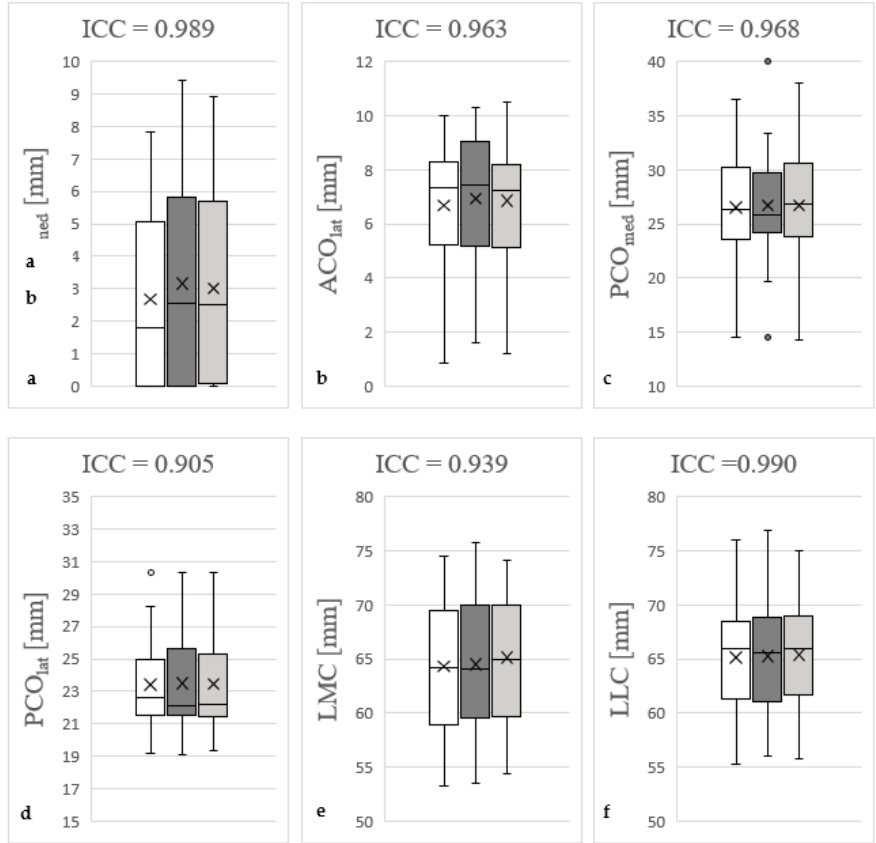
Figure 4. Determination of intraclass/interclass correlation coefficient (ICC) of medial anterior femoral condylar offset (ACO med ), ( a ); lateral anterior femoral condylar offset (ACO lat ), ( b ); medial posterior femoral condylar offset (PCO med ), ( c ); lateral posterior femoral condylar offset (PCO lat ), ( d ); length of medial femoral condyle (LMC), ( e ); and length of lateral femoral condyle (LLC), ( f ). The white box plots represent the initial measurements by Y.H., the dark grey ones represent the second recordings by Y.H. The box plots marked in light grey reflect the measurements by M.-P.M. The figures show the cumulative ICC between the initial and control measurements by Y.H. and the observations by M.-P.M. Outliers are marked with points. Excellent measurement reliability (ICC > 0.9) was determined for all measured parameters. The control measurements were carried out at intervals of two weeks by the same investigator as well as another one in blinded fashion based on 50 subjects.